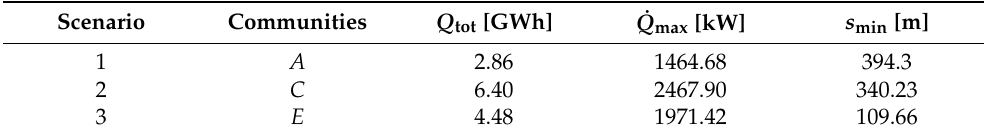
Figure 8. FZJ district heating system with hypothetical different construction site of the HPC facility and therefore different located waste heat source. Table 4. Specified separation scenarios of the FZJ district heating system for different heat source site and less available amount of